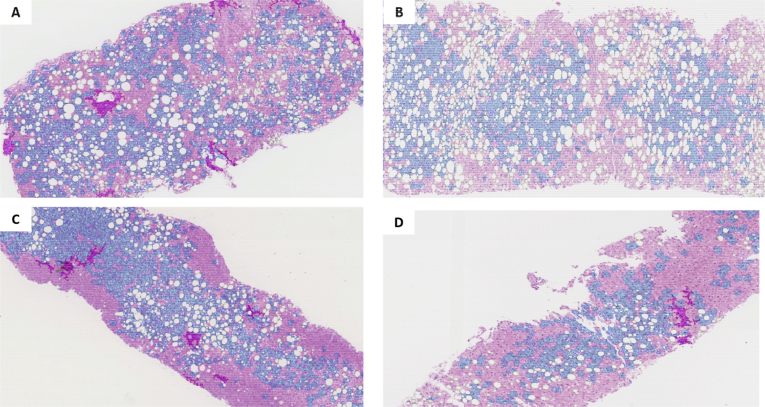
Analysis of the percentage of fat, inflammation, and ballooning in paired liver biopsy specimens. (A and B) Paired liver biopsy specimens in a patient who gained weight in a time interval of 24 months. (A) At the baseline liver biopsy, the Nonalcoholic Steatohepatitis Clinical Research Network (NASH CRN) scoring system was steatosis grade 2 (33%–66%), inflammation score of 1 (<2 foci), ballooning score of 2 (many ballooned cells), and the percentage of fat (fat%) was 19.8%, the percentage of inflammation (inflammation%) was 1.9%, and the percentage of ballooning (ballooning%) was 24.5%. (B) In the follow-up liver biopsy, the NASH CRN scoring system was steatosis grade 2 (33%–66%), inflammation score if 1 (<2 foci), ballooning score of 1 (few ballooned cells), and fat% was 30.5%, inflammation% was 0.5%, and ballooning% was 18.5%. (C and D) Paired liver biopsy specimens in a patient who lost weight during a time interval of 60 months. At the baseline liver biopsy, the NASH CRN scoring system was steatosis grade 2 (33%–66%), inflammation score of 1 (<2 foci), ballooning score of 1 (few ballooned cells), and fat% was 13.5%, inflammation% was 1.44%, and ballooning% was 32%. In the follow-up liver biopsy, the NASH CRN scoring system was steatosis grade of 1 (<33%), inflammation score of 1 (<2 foci), ballooning score of 1 (few ballooned cells), and Fat% was 6.49%, inflammation% was 1.28%, and ballooning% was 17.6%.